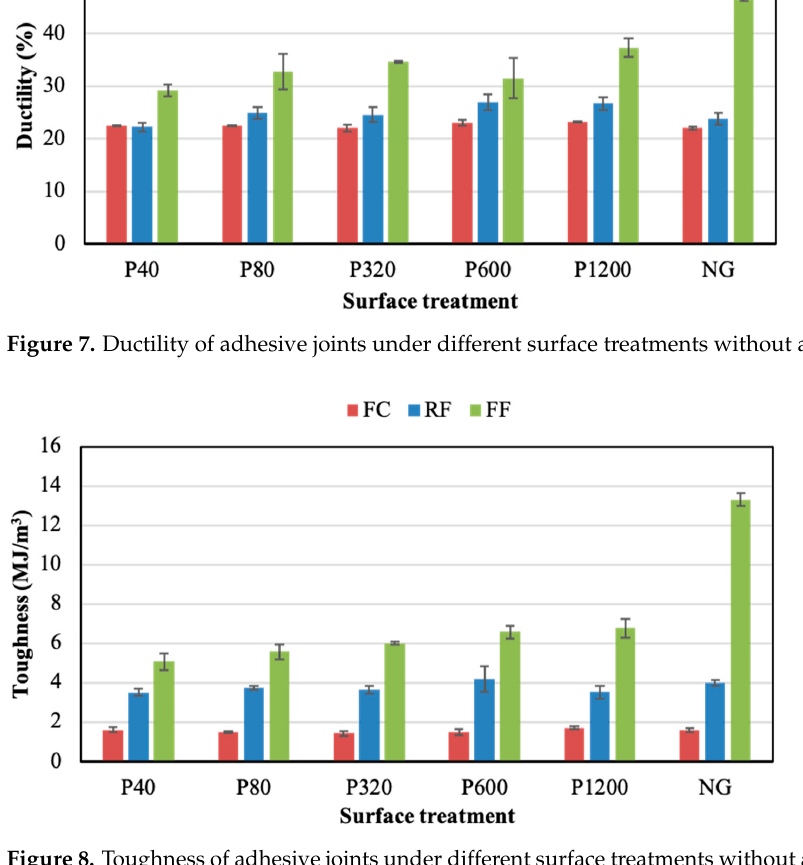
Figure 8. Toughness of adhesive joints under different surface treatments without adhesion pro- moter.